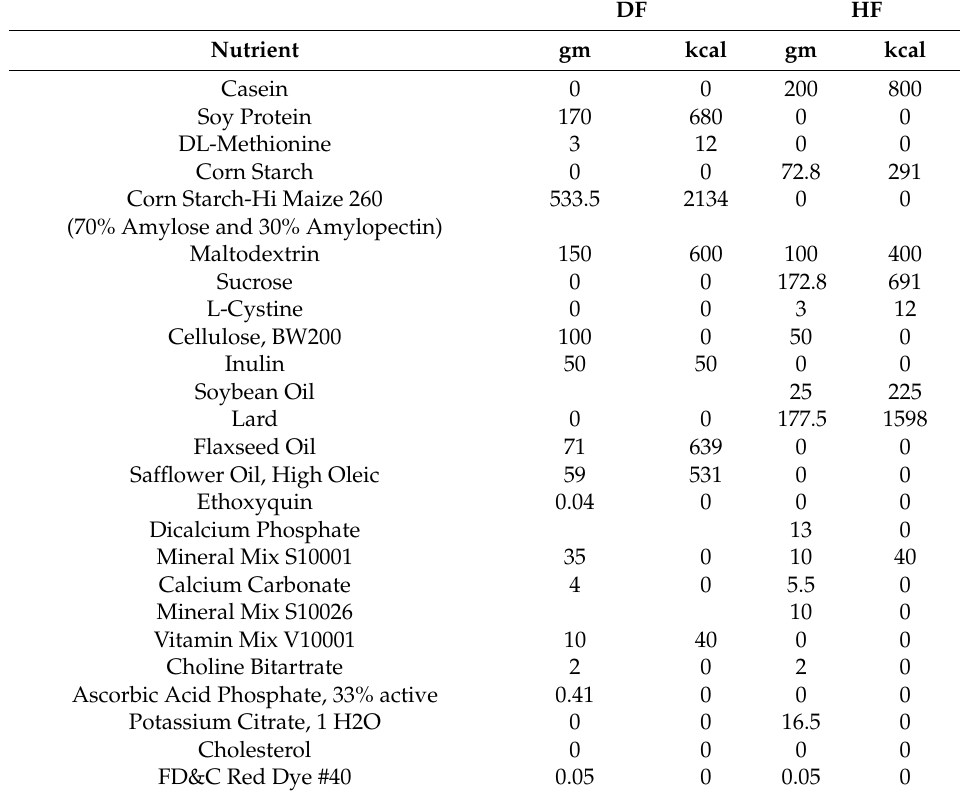
Table 2. Nutrient composition of Daniel Fast and high-fat